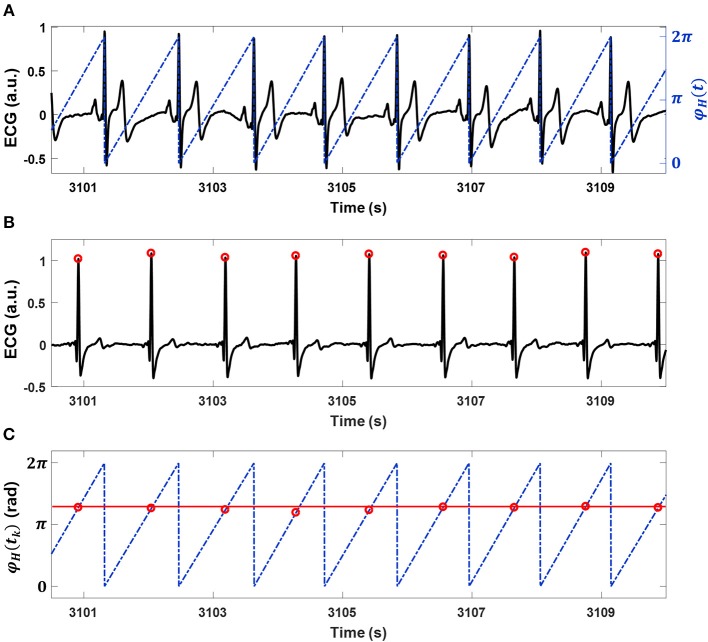
Interindividual heart rhythm phase synchronization (IHPS) and the synchrogram method. (A) A subject's electrocardiogram (ECG; black line) with the cyclic phase (blue dashed line) φH (t) expressed from 0 to 2π for consecutive R-peak locations. (B) An ECG (black line) and its R-peak locations (red dots) for a co-sleeping individual. (C) The synchrogram for heart rhythms in a pair of co-sleepers; each R-peak location of the ECG in (B) is placed at the corresponding location of the cyclic phase φH(t) on the ECG in (A). One parallel horizontal line (red line) indicates 1:1 phase synchronization between the heart rhythms. IHPS is determined for different n:m ratios, where n is the number of heartbeats from one individual synchronized with m heartbeats from the co-sleeper.